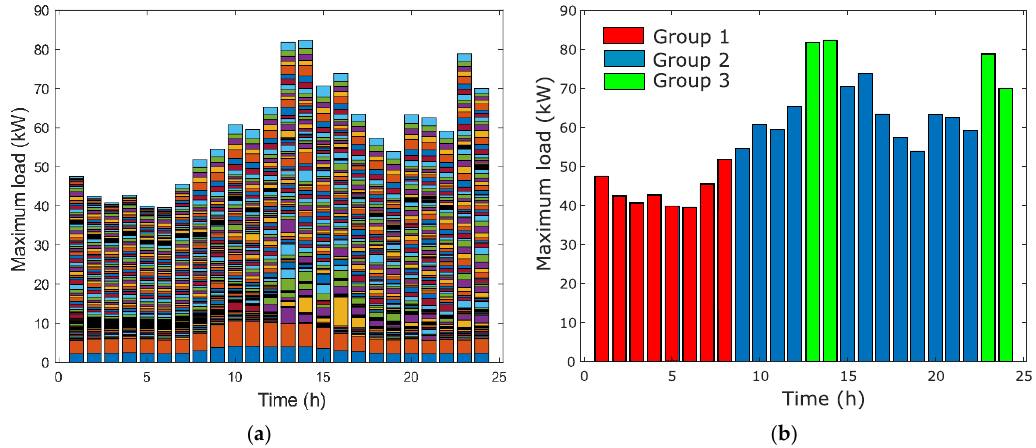
Figure 5. Maximum demand: ( a ) stacked load of 90 users; ( b ) selection of groups for loading with DR.